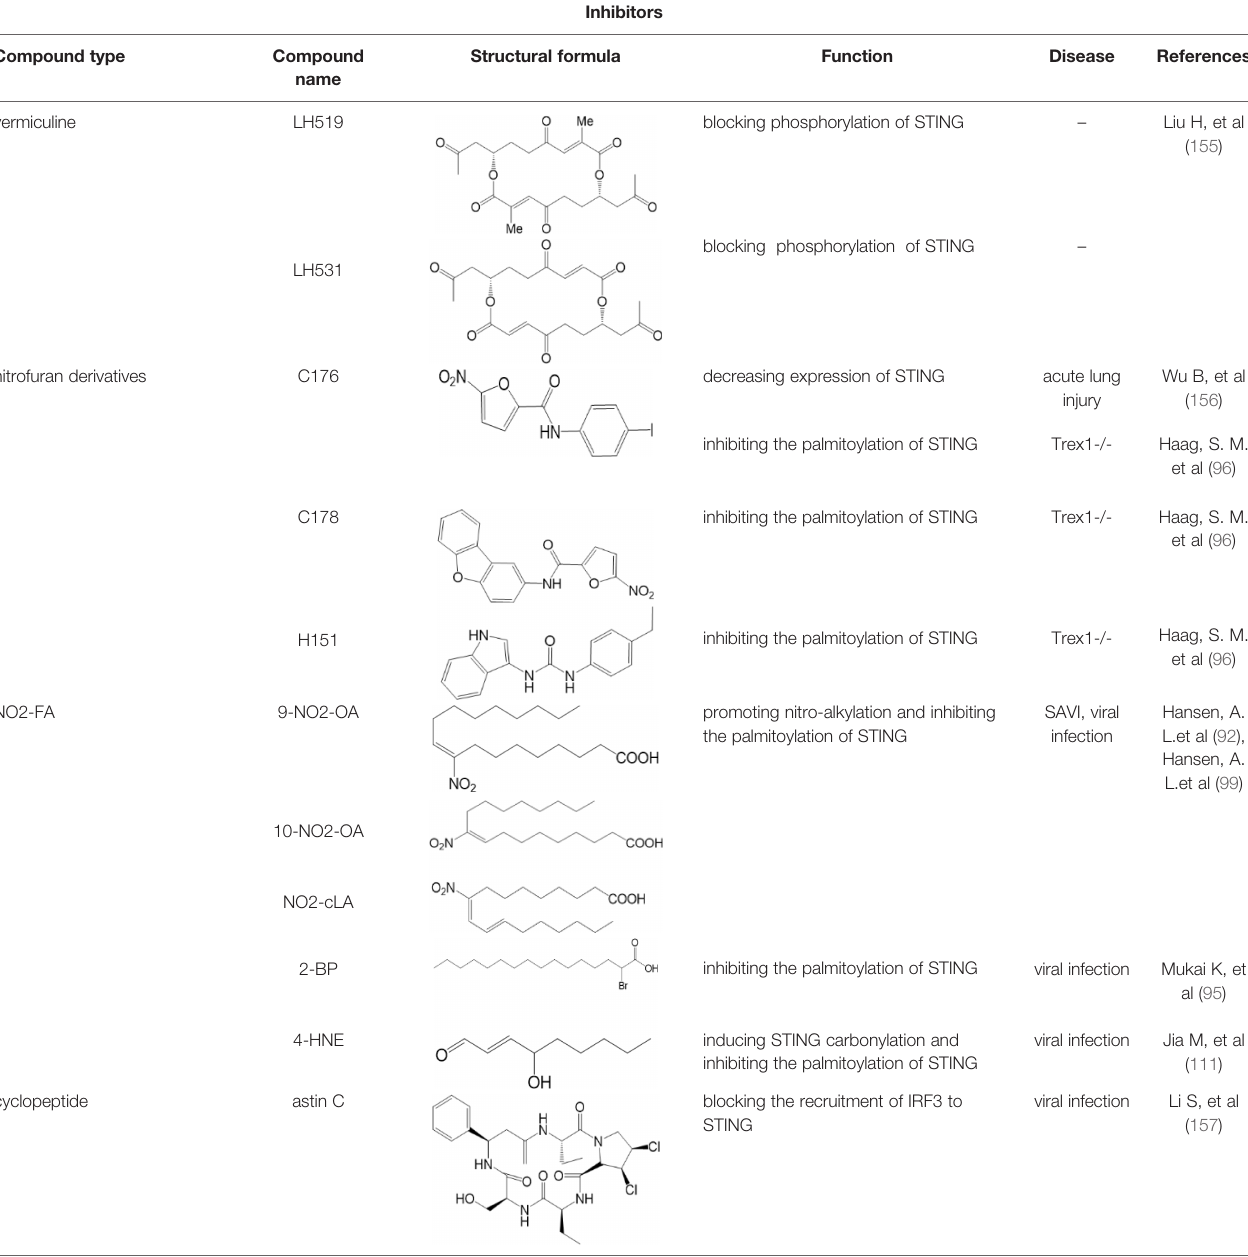
TABLE 2 | Structure and function of STING agonists and